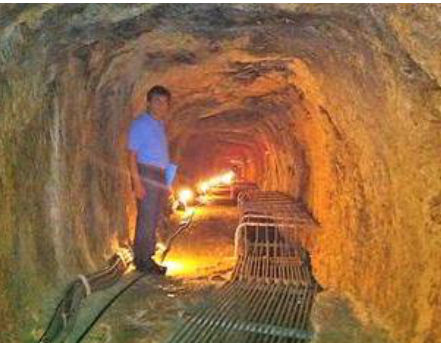
Figure 5. A view of the Eupalinos tunnel with the aqueduct channel on the right-hand side of the picture (with permission of K. Voudouris).